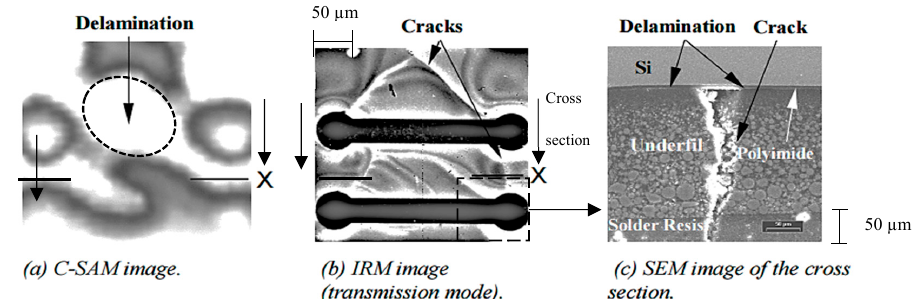
Figure 15. Representative images of defects in a sample specimen obtained by ( a ) C-SAM, ( b ) IRM, and ( c ) zoomed cross section of the specimen using SEM (zoomed area is marked on the IRM image) [100].